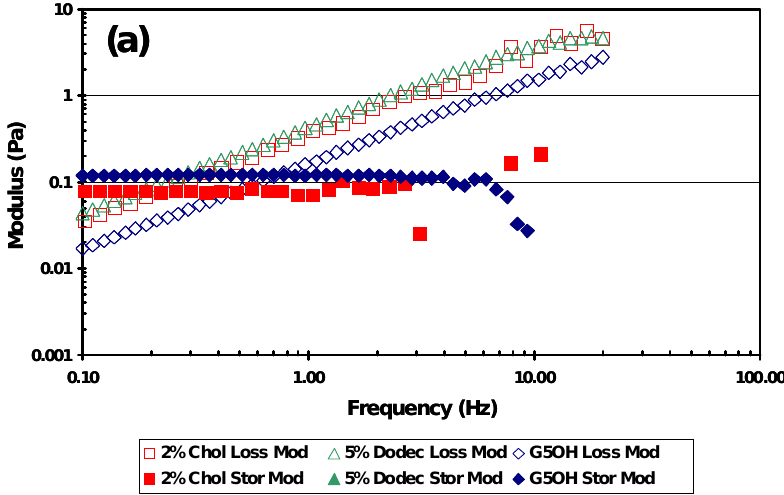
Figure 7. Rheological results from the Vilastic capillary rheometer. All experiments were performed at 37 °C. Dendrimers were tested at 34% w/w in PBS and lens crystallins were at physiological concentrations (~34% w/w) (a) Frequency scan at a shear rate of 20 s -1 comparing loss modulus and storage modulus of 2% cholesteryl (C2), 5% dodecyl (D1) OH unmodified dendrimers. (b) Shear rate scan at a frequency of 2Hz, modified and G 5 comparing the loss modulus of C2, D1 modified and G OH unmodified dendrimers with 5 porcine lens crystallins (c) Shear rate scan at a frequency of 2Hz, comparing the storage OH unmodified dendrimers with porcine lens modulus of C2, D1 modified and G 5